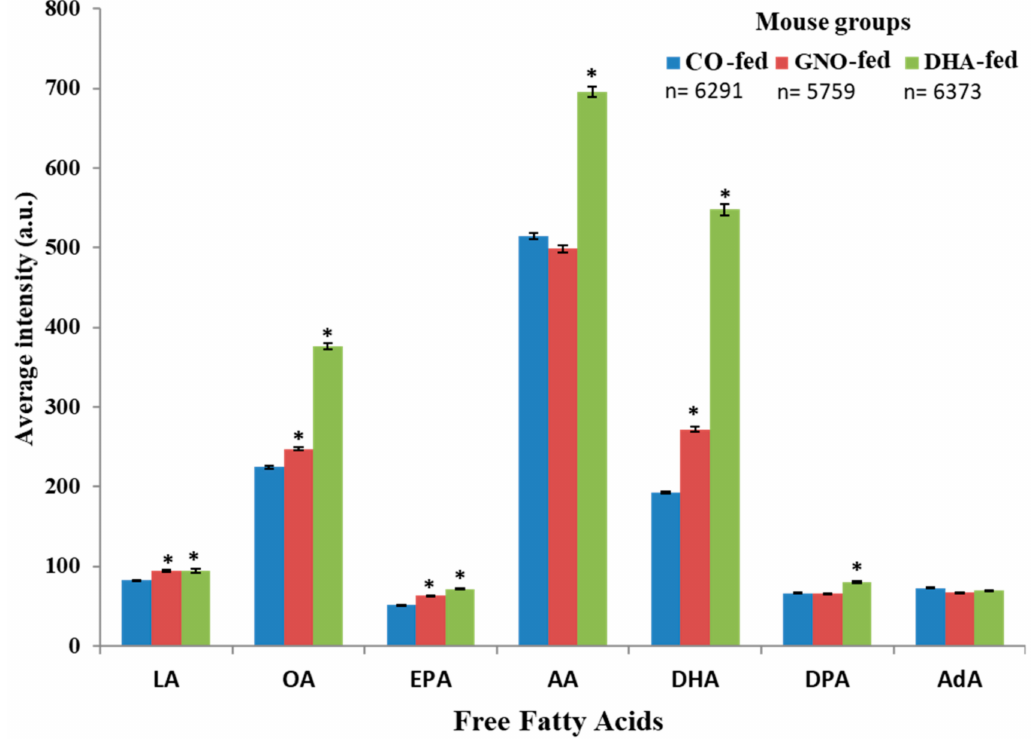
Figure 3. Average intensity (arbitrary unit; a.u.) of DHA and other free fatty acids in sagittal slices of SAMP8 mouse brains. All data are expressed as mean ± SEM. * indicates p < 0.001 compared to CO, and n indicates the number of